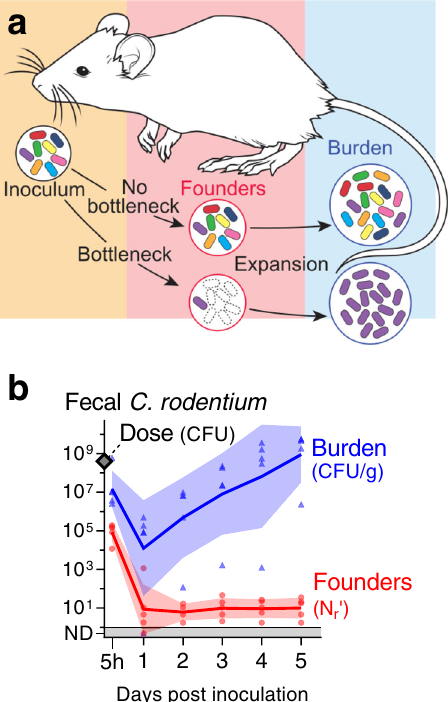
Fig. 1 | A constrictive bottleneck impedes C. rodentium enteric colonization. a Experimentalstrategy.Toquantifythecontraction(bottleneck)ofthe C.rodentium population during colonization a barcoded library of bacteria was orally adminis- teredtomice.Thenumberofuniquecellsfromtheinoculum(founders)thatexpand to produce the observable population(burden)was determined fromthe frequency and diversity of barcodes. b 5 cohoused, adult, female, C57BL/6J mice were admi- nistered 4×10 8 CFU STAMP-CR253 by oral gavage and the C. rodentium population was monitored in the feces for 5 days post inoculation (p. i.). Dose and burden were enumerated by serial dilution and plating; founders were determined by STAMP. Lines and error are geometric means and standard deviation. Bacteria not detected (ND) counted as 0.5, CFU colony forming units, g grams. Validation of STAMP libraries in Supplemental Fig. 1. Source data are provided as a Source Data fi